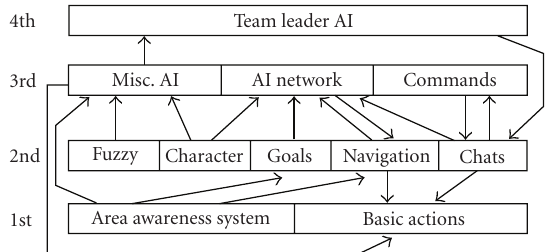
Figure 1: The Quake III bot architecture as described in the developer documentation. This figure shows the close coupling between the various levels of abstraction (Copied from [28]).